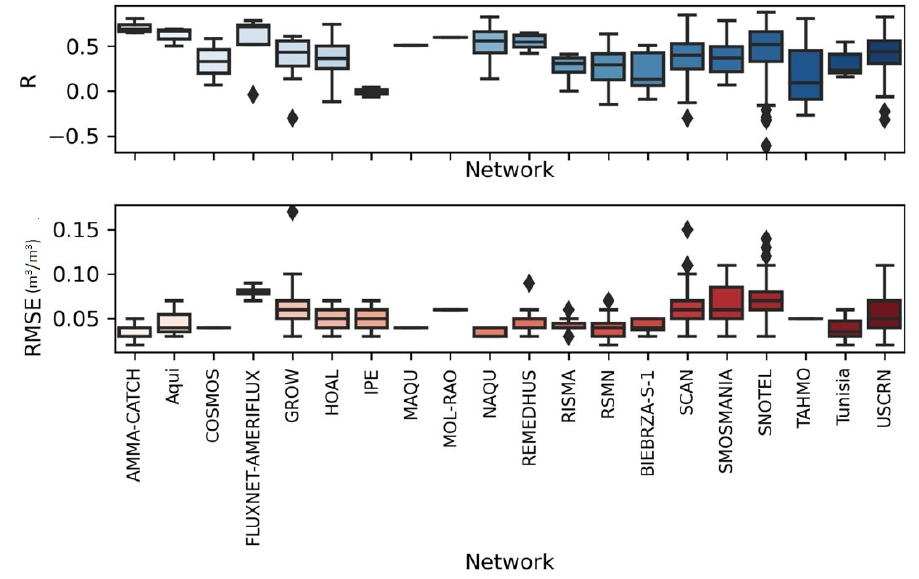
Figure 4. Boxplots of statistical parameters ( R and RMSE ) of soil moisture retrieval as a function of ISMN-considered networks using the hybrid methodology of change detection and ANN.